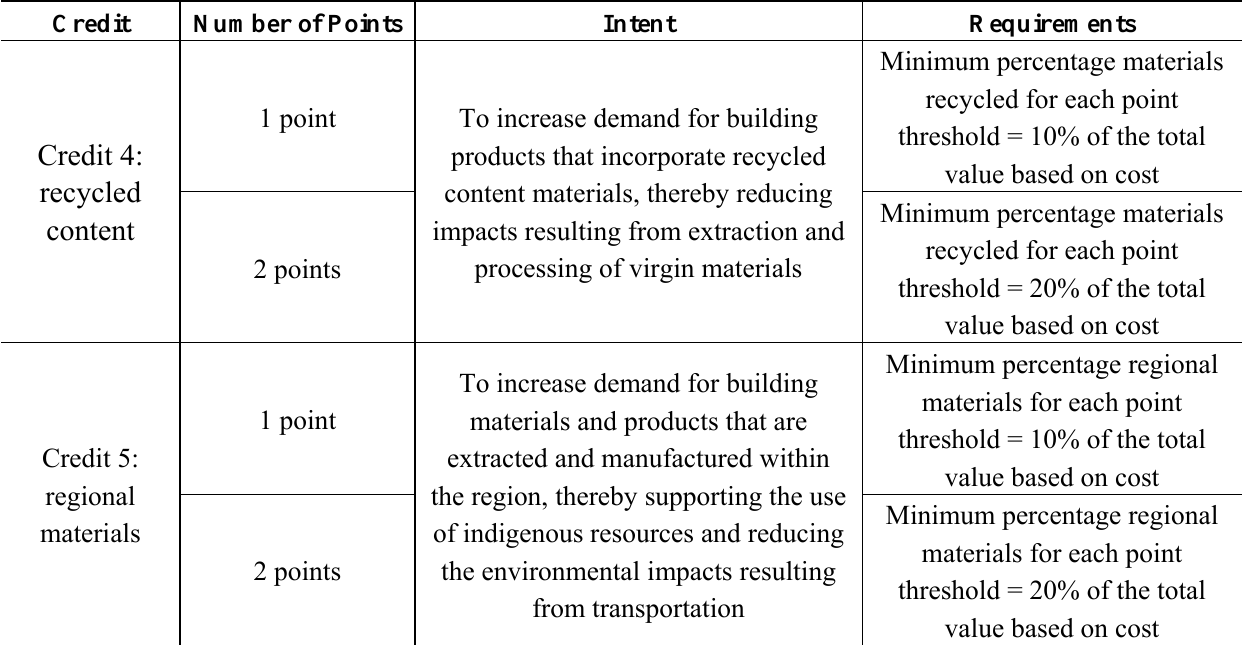
Table 1. Leadership in energy and environmental design (LEED) credits considered in this research. Credit Number of Points Intent